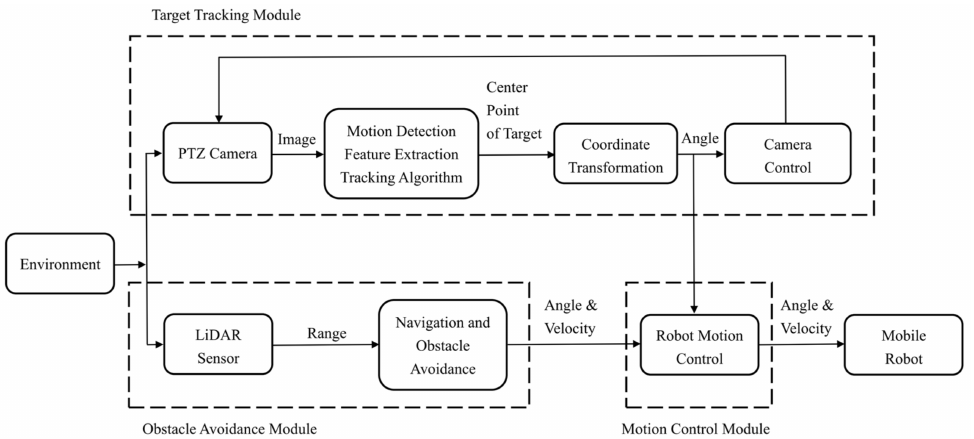
Figure 3. System module